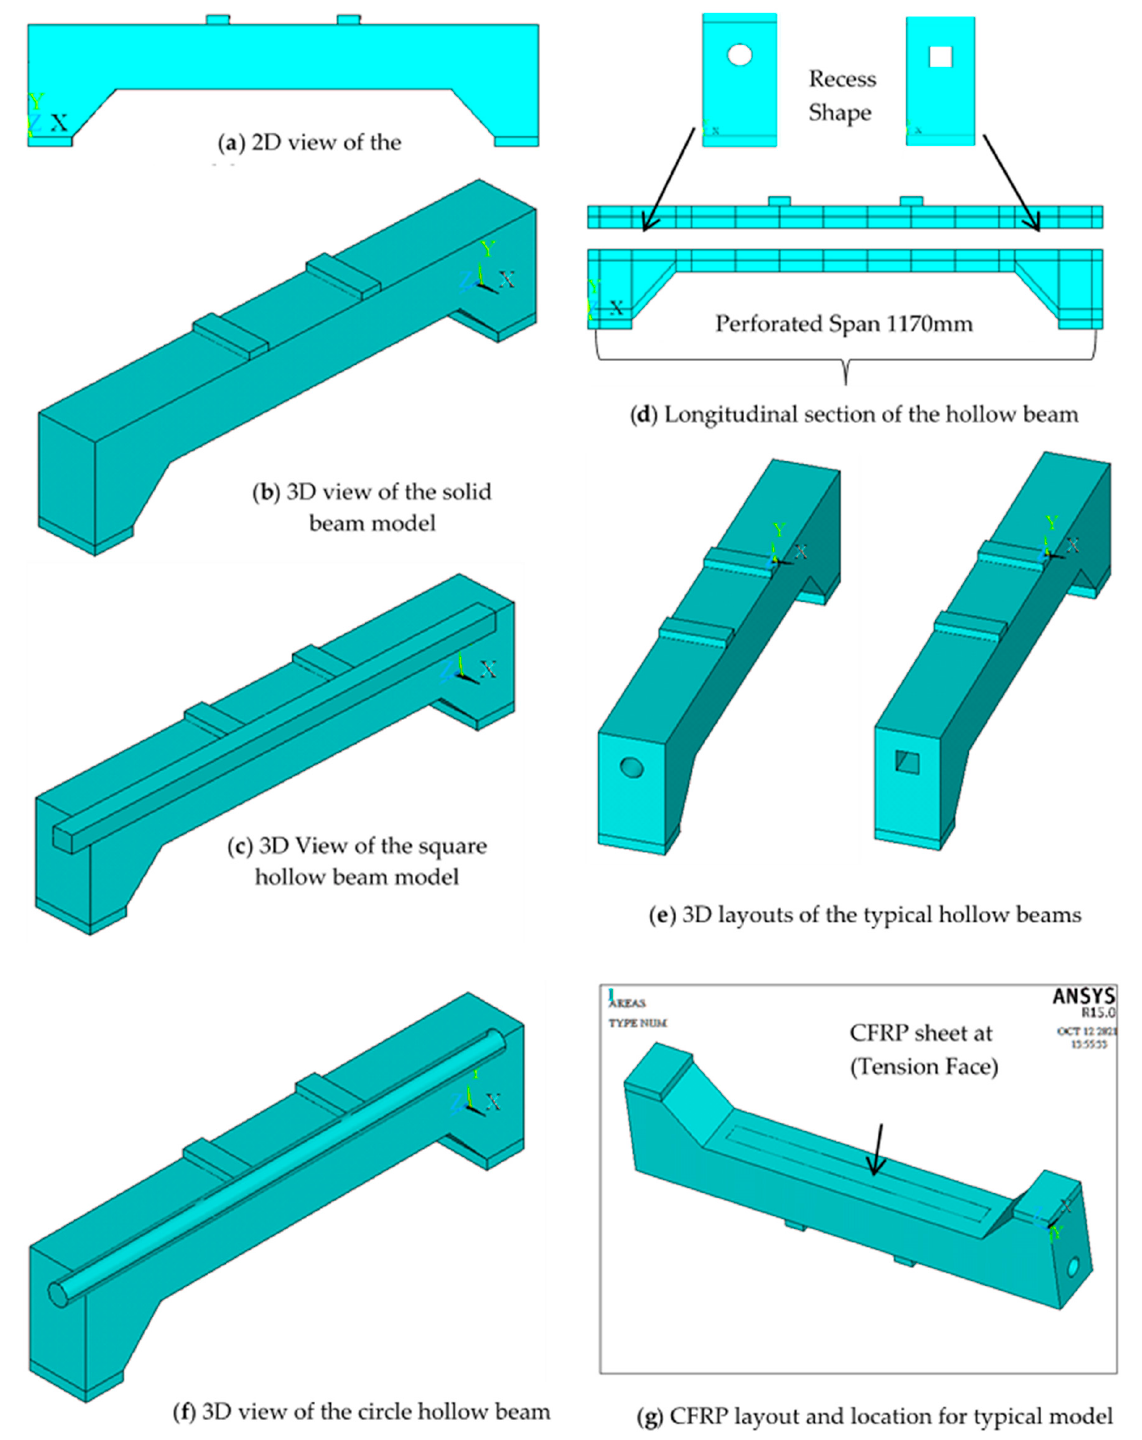
Figure 4. Modelling procedures for typical non-prismatic RC beam models.